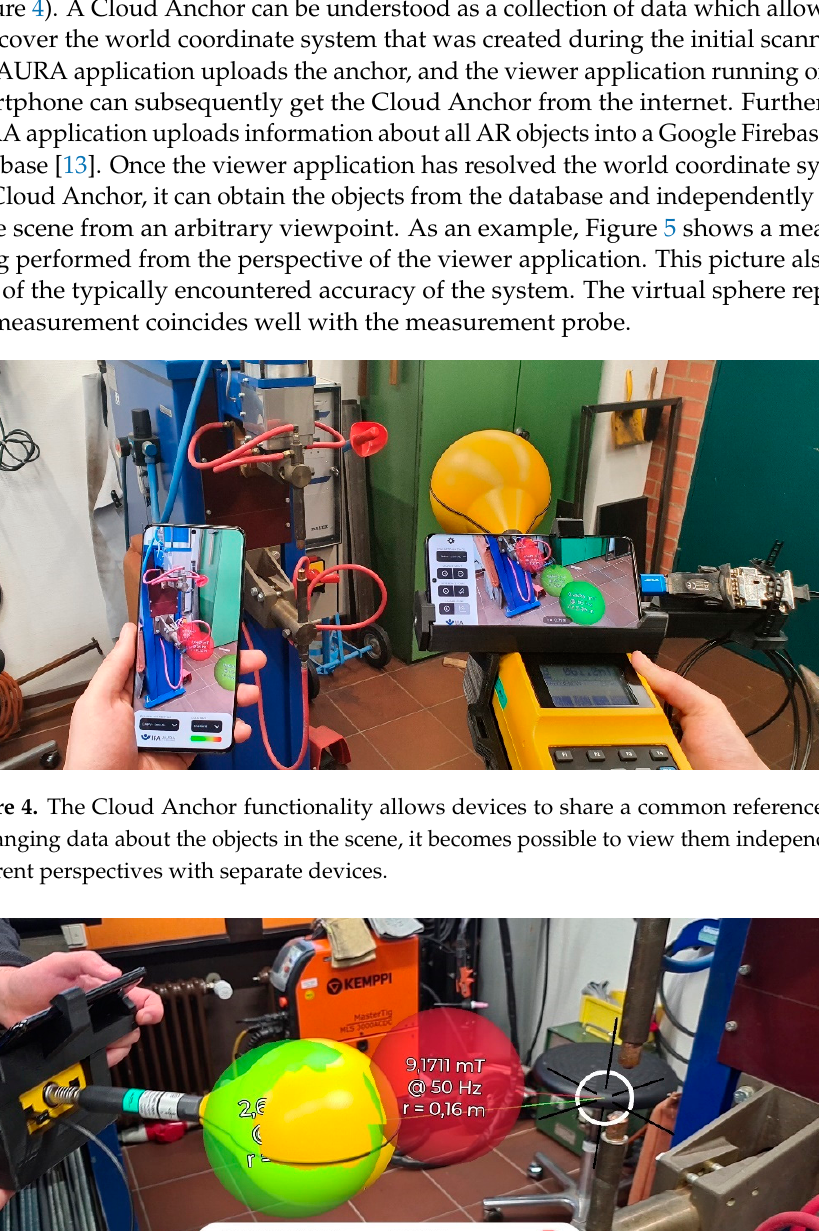
Figure 3. The hazard zone represents a volume within which the measured flux densities exceed a given limit value. In other words, it visualizes safety distances around the reference point. The di- mensions can be estimated based on the measurements, and they can be manually adjusted.